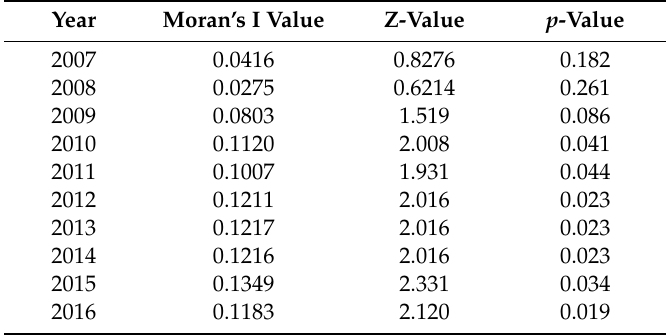
Table 5. The test of spatial autocorrelation of transportation carbon emissions.